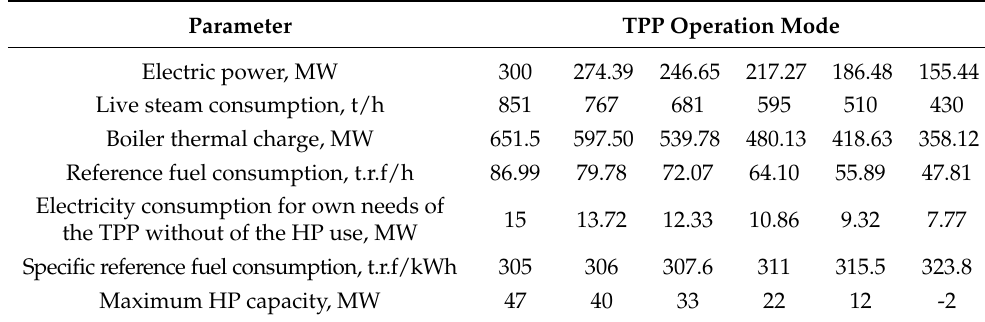
Table 3. The main parameters of TPP based on steam turbine type K-300-170 with HP.